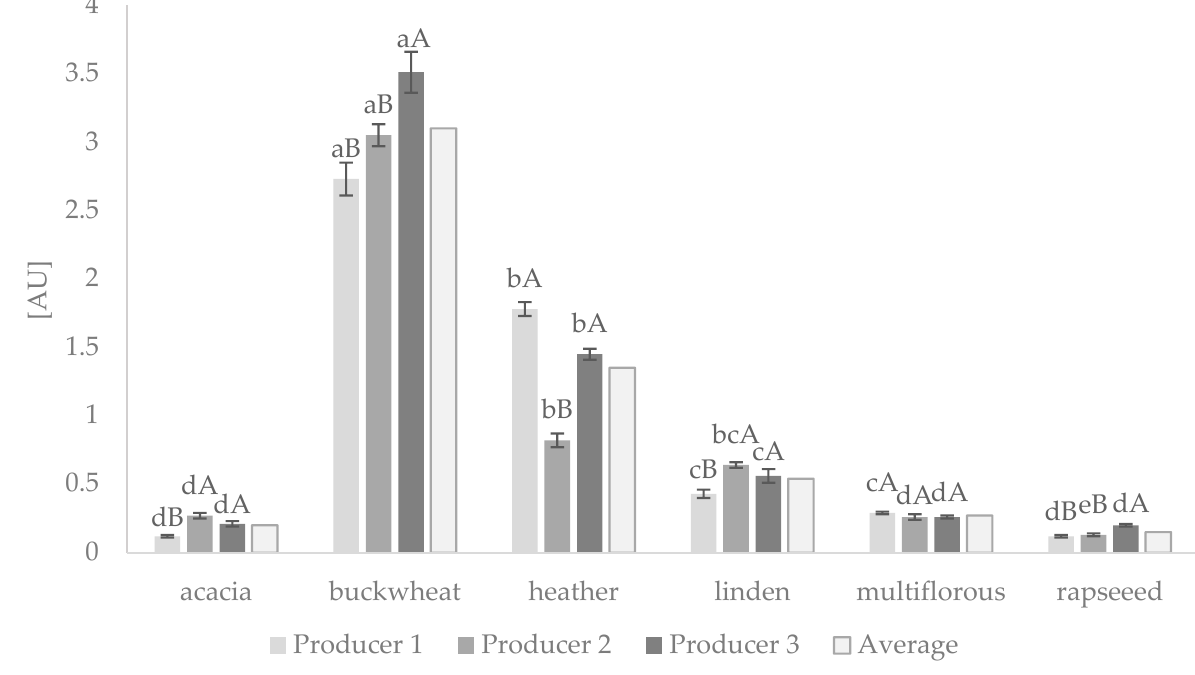
Figure 1. The degree of browning of honey samples from three different producers. The peaks are presented as the mean ± standard deviation. a–e Values followed by different letters are significantly different between each type of honey ( p < 0.05); A,B values followed by different letters are significantly different between producers 1, 2, and 3 ( p < 0.05), as determined by the Tukey’s multiple comparisons test.